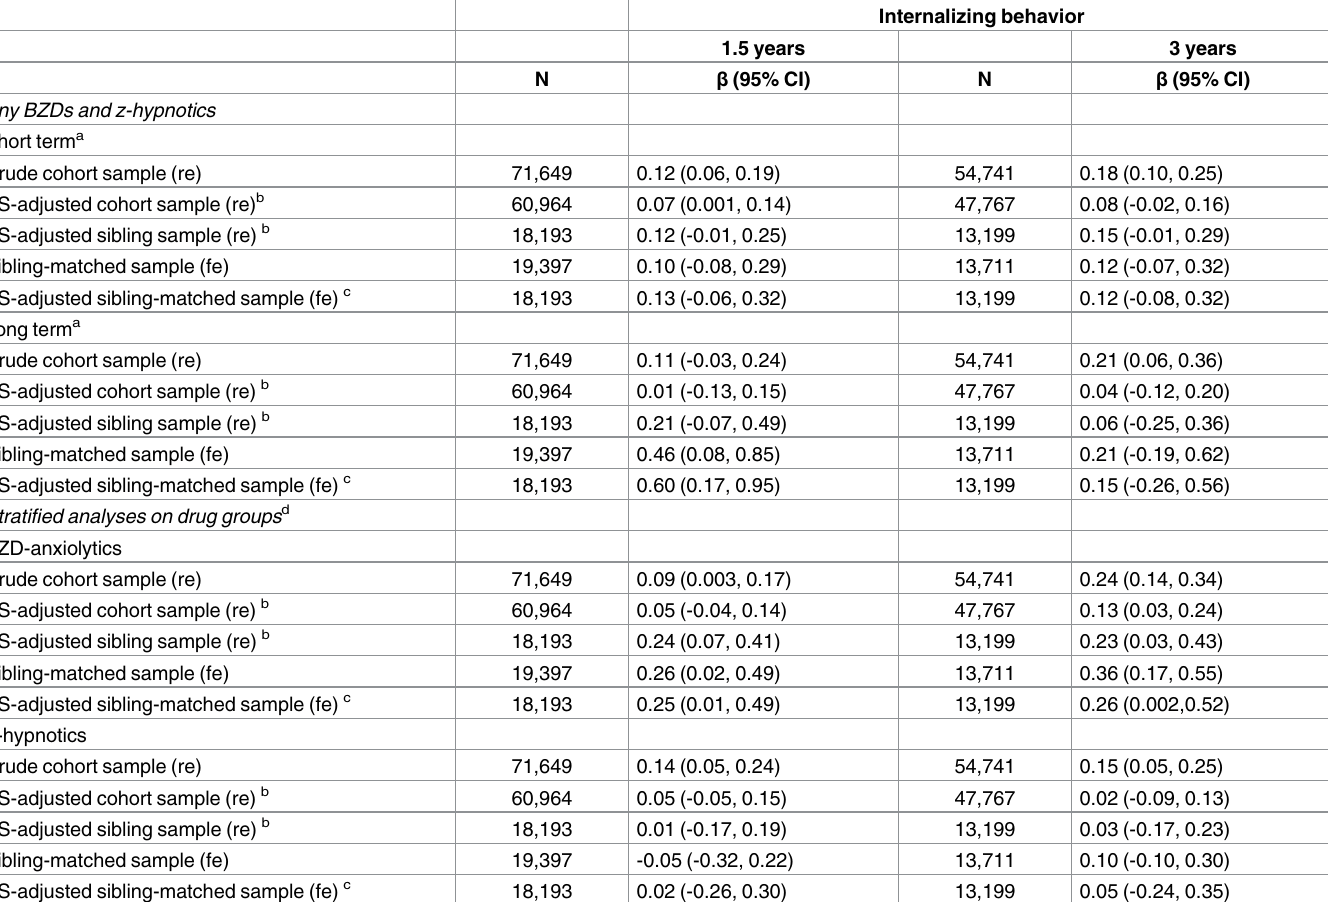
Table 4. Full cohort and sibling-matched linear regression models: Parameters for differences in internalizing behavior score predicted by in utero exposure to BZDs and